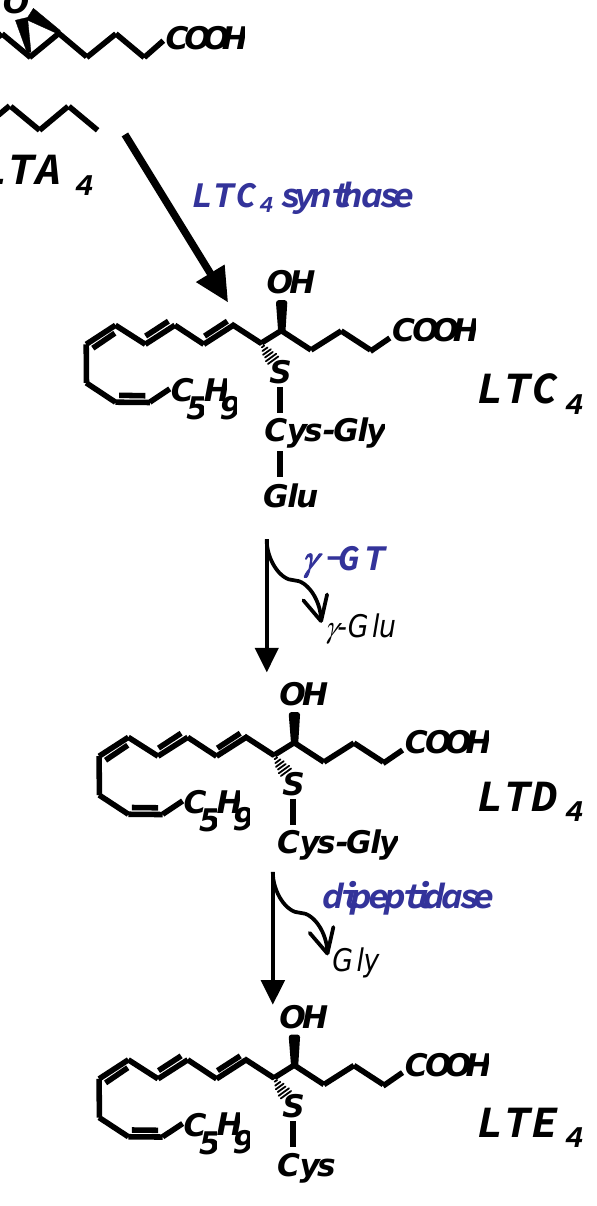
FIGURE 3. Schema of the leukotriene metabolic